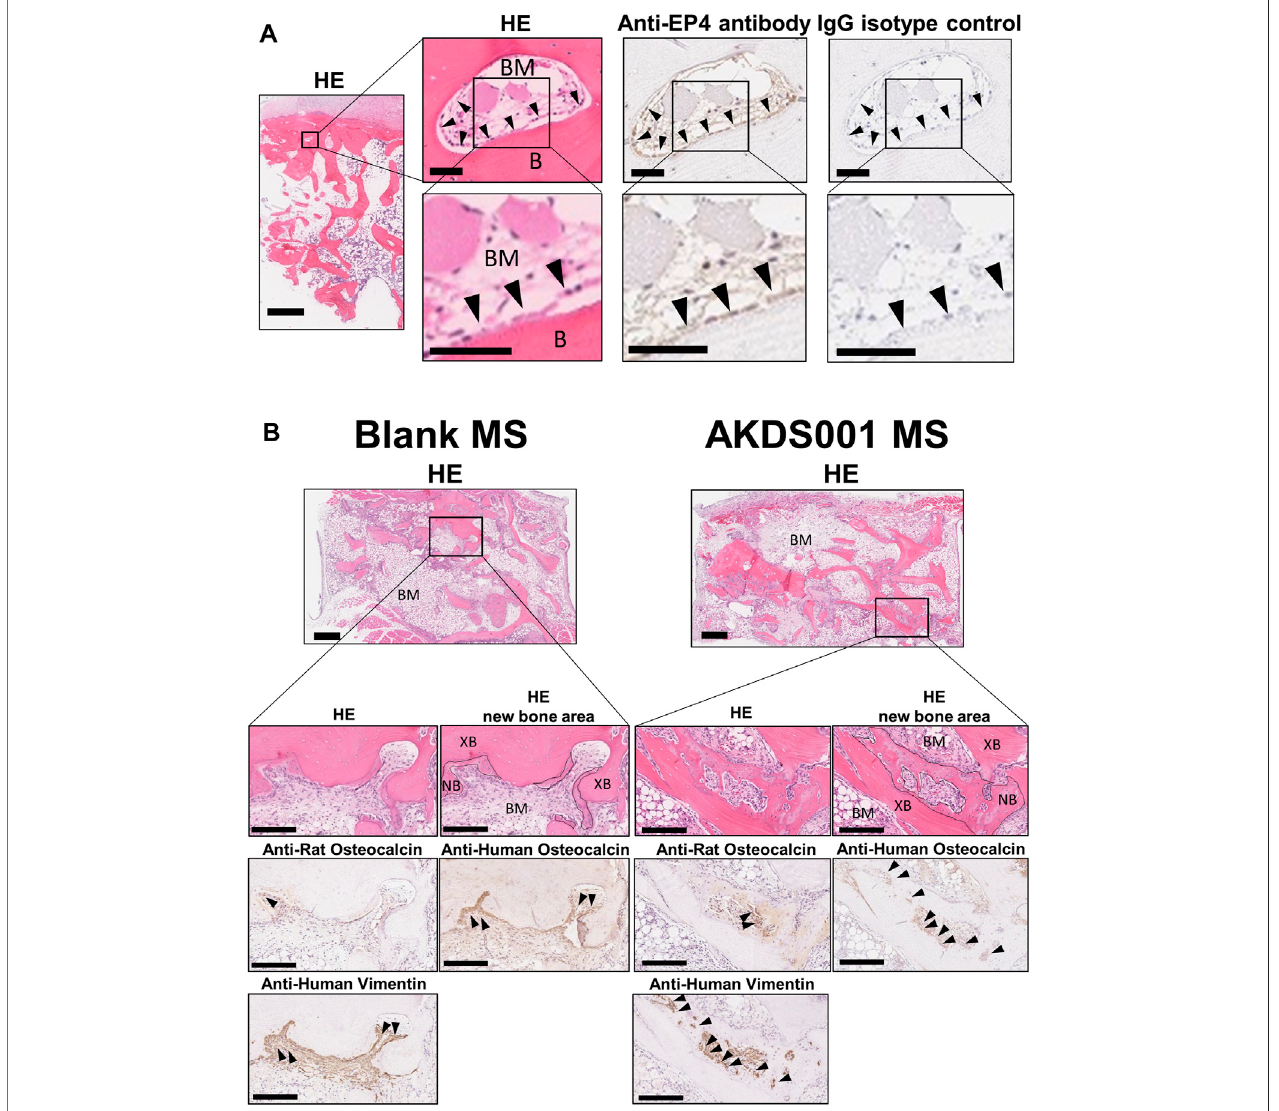
FIGURE 2 | Histological images of human bone and extracted samples. (A) Representative images of hematoxylin and eosin (HE) staining, and anti-EP4 and IgG controlimmunostainingofhumanvertebralbone.Arrowheadsindicate representative anti-EP4immunostaining-positive osteoblasts. B,Bone;BM,bone marrow.Scale bars,1 mm(lowmagni fi cation),50 μ m(mediummagni fi cation),and 50 μ m(highmagni fi cation). (B) Representativeimages ofHEstainingandanti-humanvimentin, anti- rat osteocalcin, anti-human osteocalcin immunostaining. Boundary lines of new bone are drawn on HE staining. Arrowheads indicate representative immunostaining-positive cells. XB, xenografted bone; NB, new bone; BM, bone marrow (stroma between xenografted bone). Scale bars, 500 μ m (low magni fi cation) and 200 μ m (high magni fi cation).